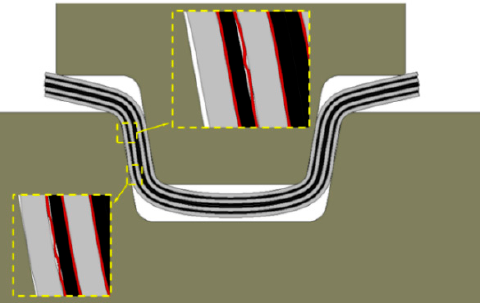
Figure 10. Predicted delamination at the metal–polymer interface in a semi-deformed profile with L2 in the middle forming stages.